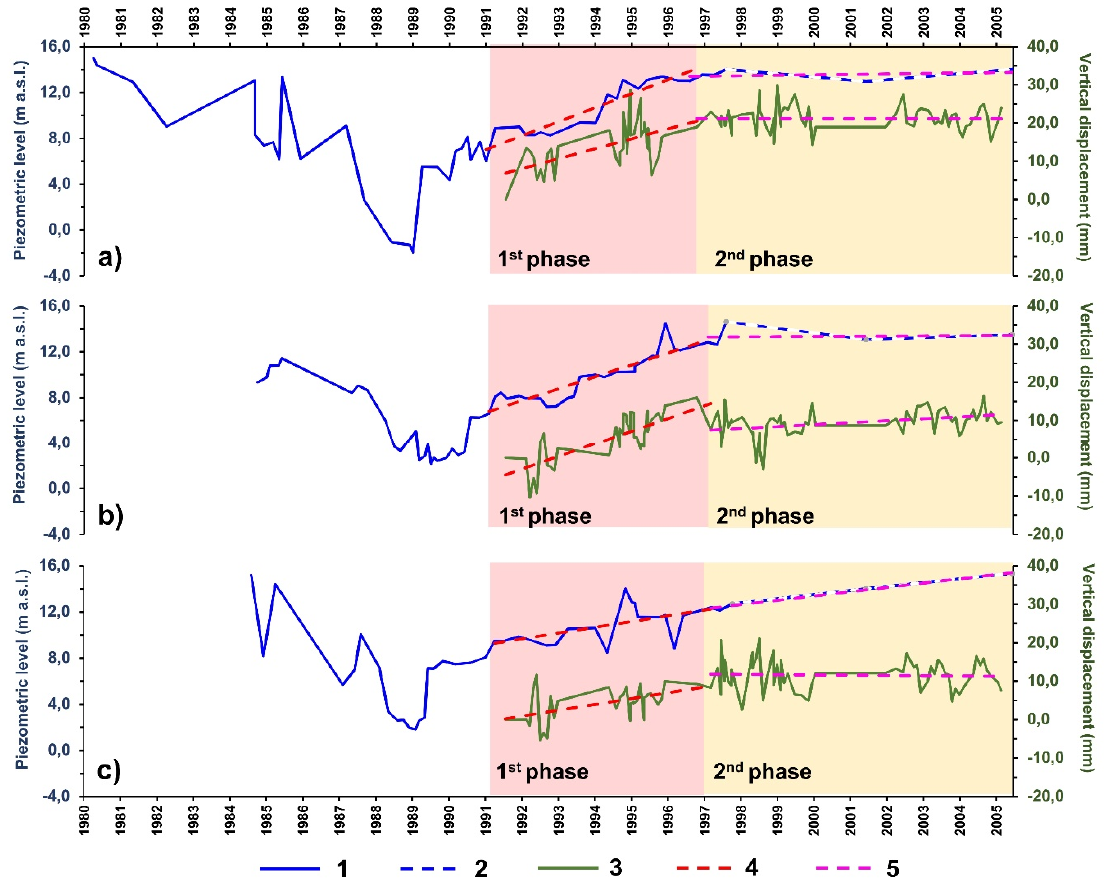
Figure 10. Piezometric levels and vertical displacement of the wells 22A ( a ), 119 ( b ) and sn2 ( c ). Legend: 1) piezometric level (m a.s.l.); piezometric level interpolated (see Figure 3c,d) (m a.s.l.); 3) vertical displacement (mm); 4) trends in the first phase; 5) trends in the second phase.